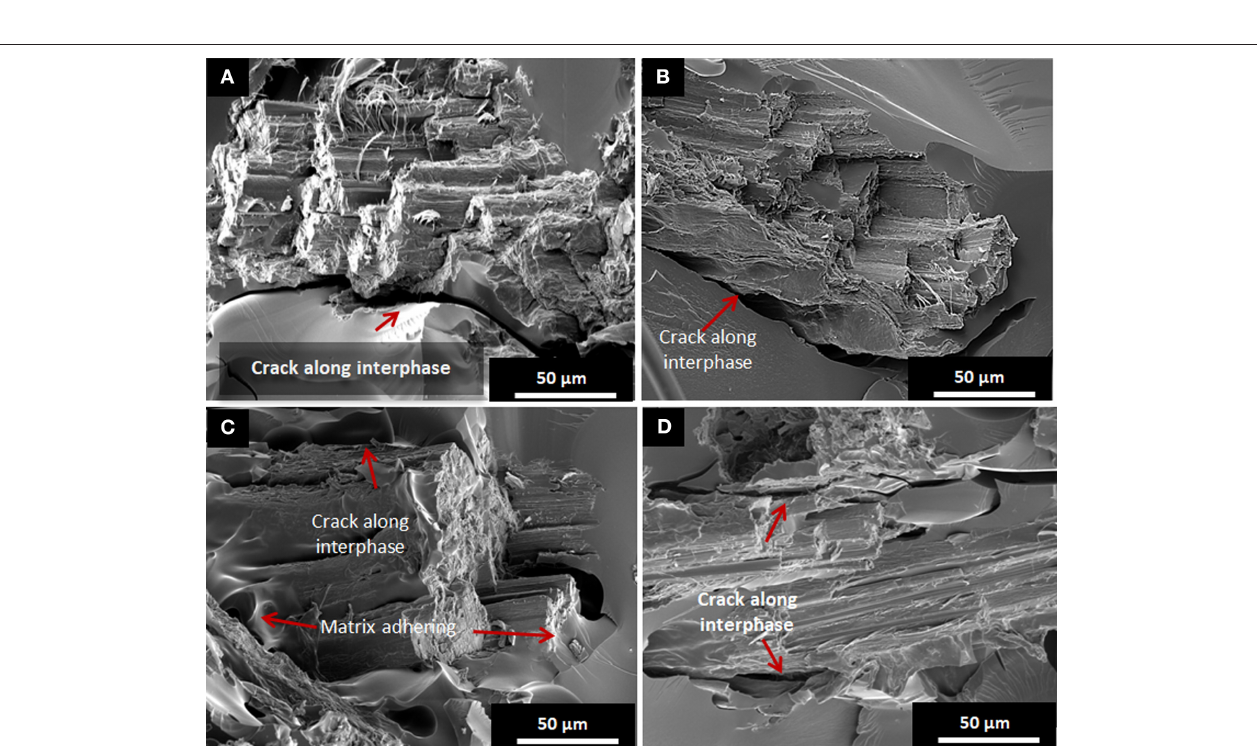
FIGURE 9 | SEM images of flexural fracture surfaces after water absorption test (A) UTKC, (B) ATKC, (C) AHTKC, and (D) HTKC.